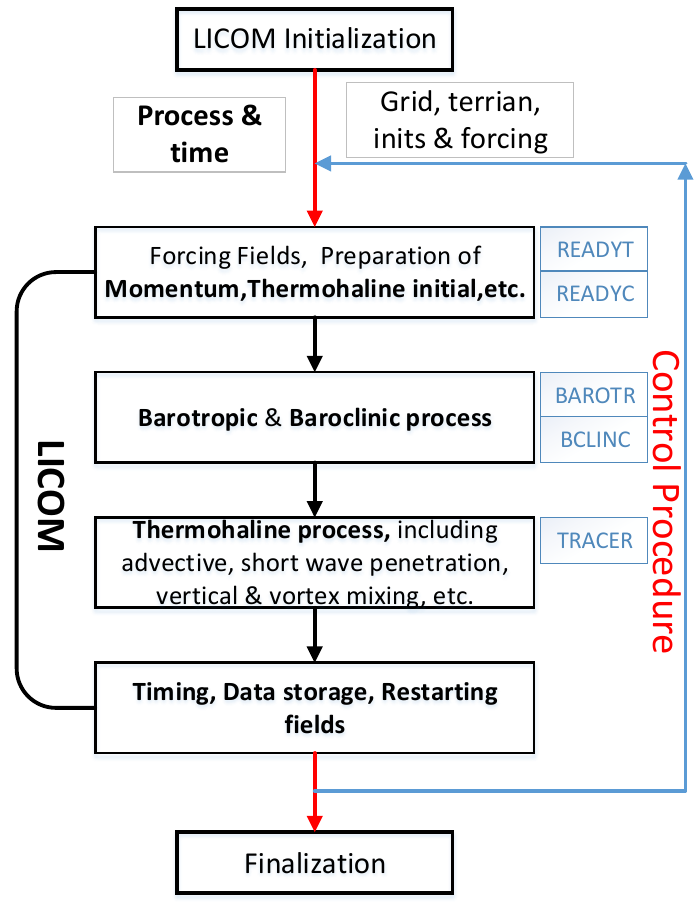
Figure 1. The control flow of